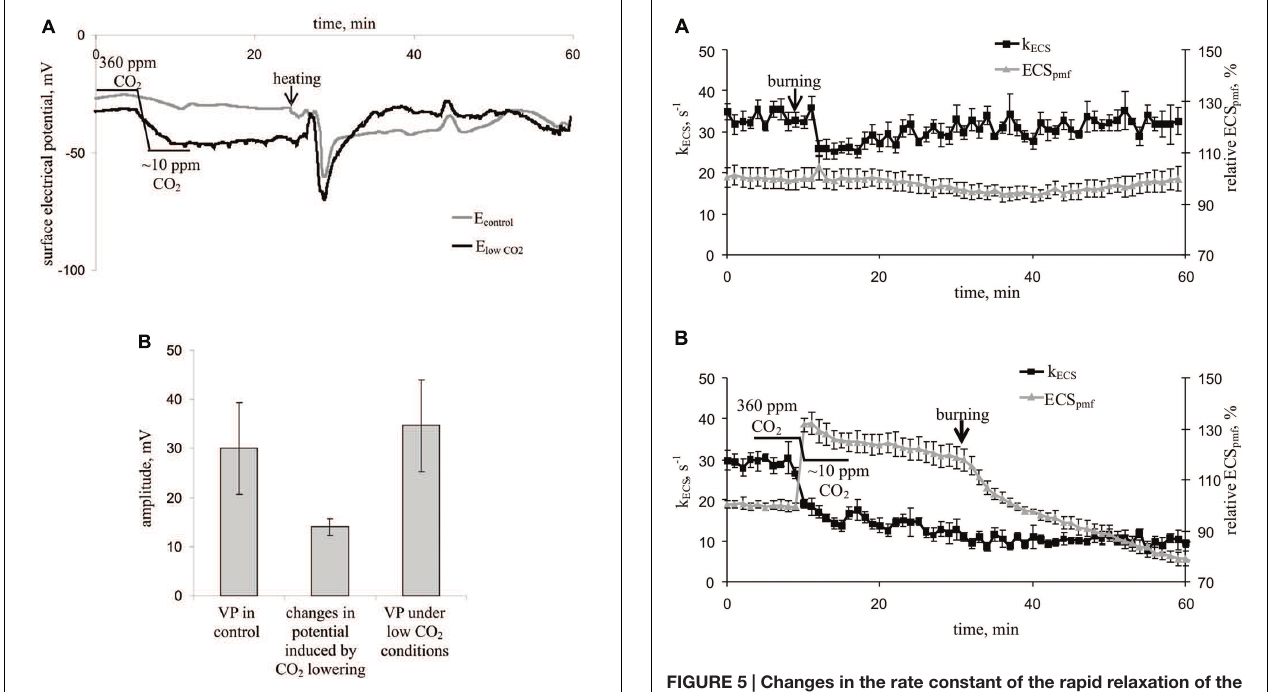
FIGURE 4 | Influence of decreasing the CO 2 concentration on the surface membrane potential and VP in leaves ( n = 7). (A) Changes in the surface electrical potential in leaflets at approximately 10 ppm CO 2 concentration (E low CO ) and in control leaflets (E control ). (B) Mean VP and CO 2 2 decrease-induced changes in the surface potential. Significant differences between variants in Figure 4B were absent (Student’s t -test). TABLE 2 | Relative changes in the ECS and LS parameters after VP induction and CO 2 concentration decrease. VP at 360 ppm CO 2